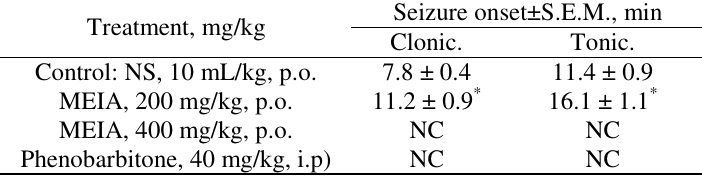
Table 4. Effect of MEIA on picrotoxin-induced seizure in mice Seizure onset±S.E.M., min Treatment, mg/kg Clonic. Tonic. Control: NS, 10 mL/kg, p.o.